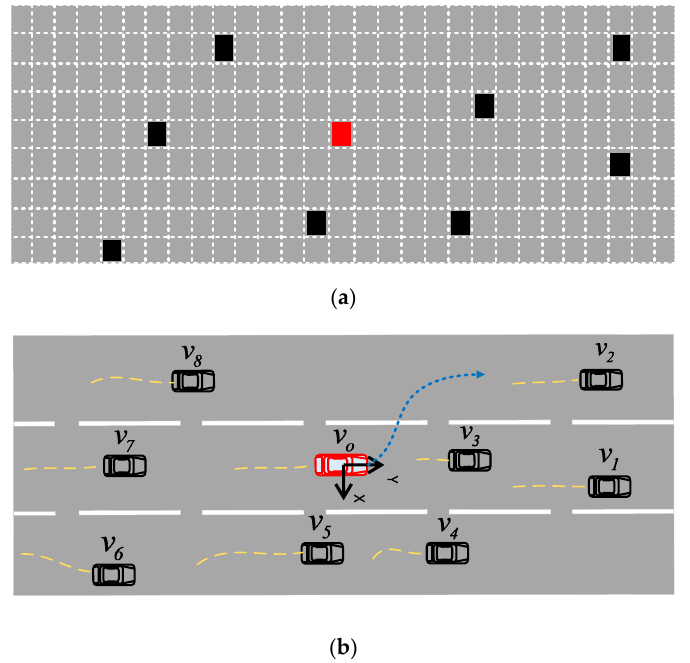
Figure 2. Research scenario of RA-LSTM. ( a ) represents the gridding of lane change scenes; ( b ) represents a lane change scenario